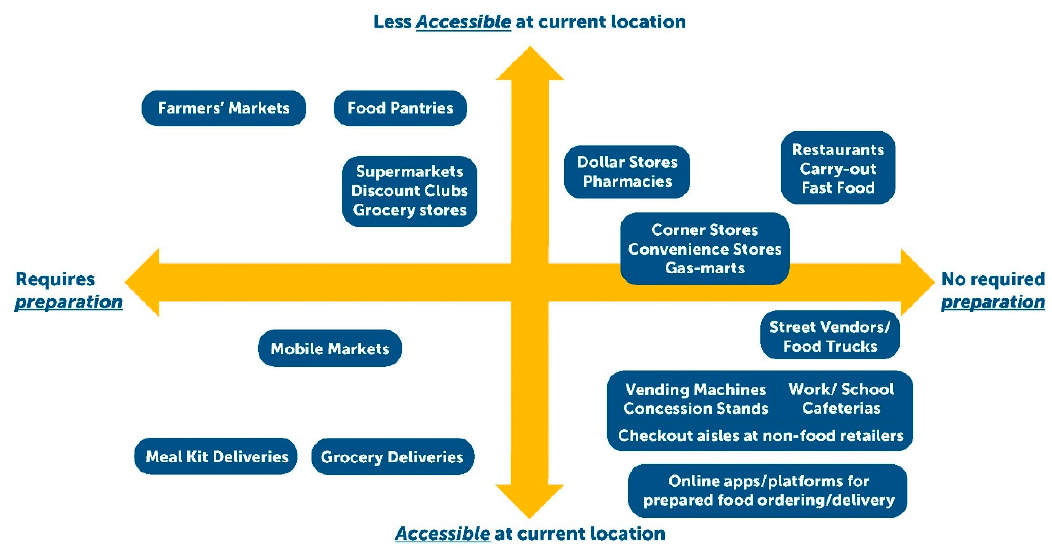
Figure2. Figure 2. Common and Emerging Retail Food Sources across Two Dimensions of Customer